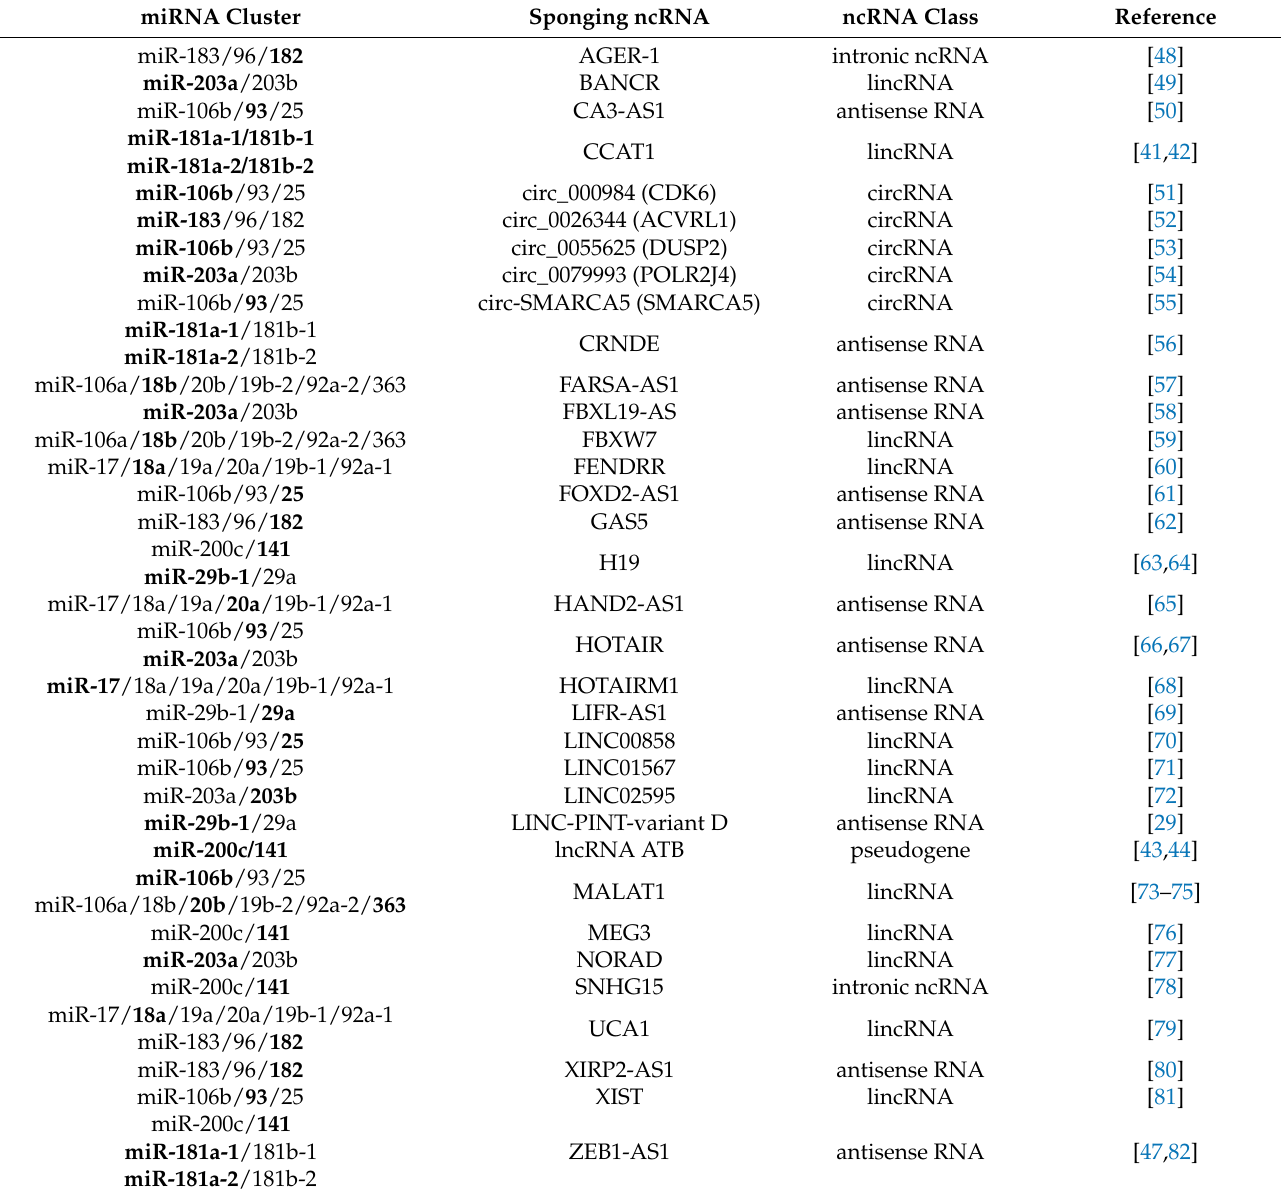
Table 2. List of lncRNAs and circRNAs sponging up-regulated miRNA clusters in human CRC cell